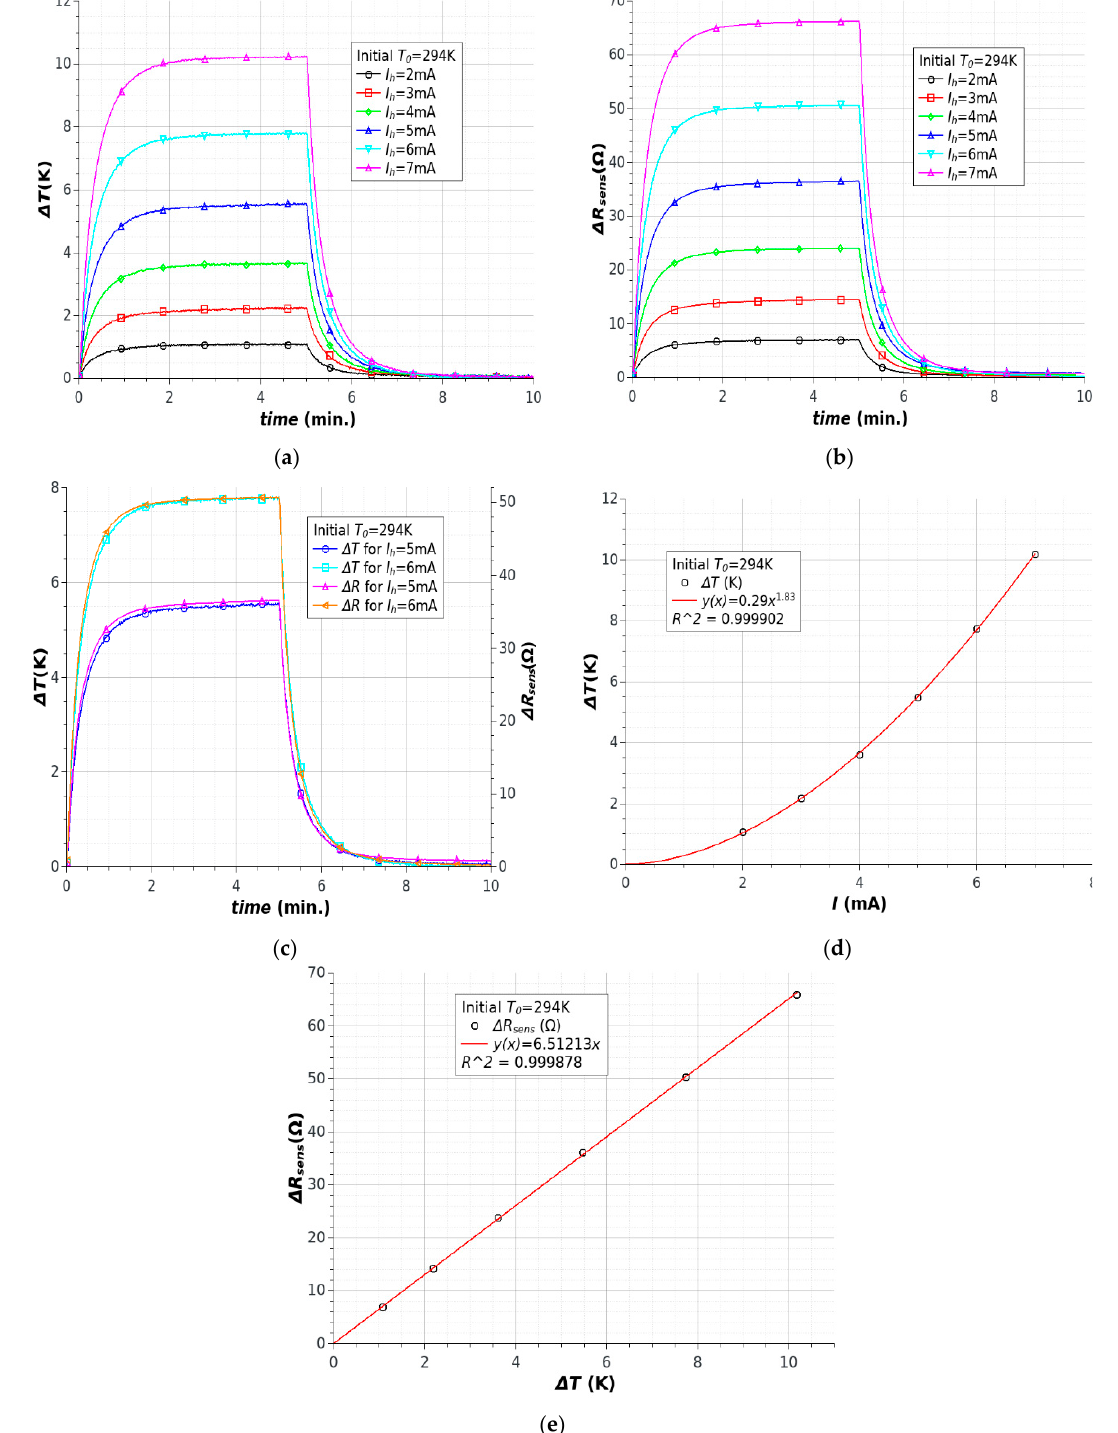
Figure 6. Heating of microstructures at room temperature: ( a ) temperature changes; ( b ) sensor resistance changes; ( c ) relationship between temperature changes and sensor resistance changes during heating process; ( d ) temperature changes due to heater current value; ( e ) relationship between sensor resistance changes and temperature changes.